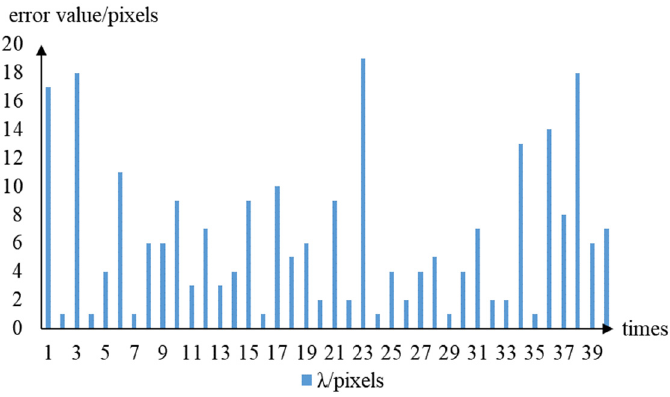
Figure 16. Pixel error value of lower extreme point. Abscissa, number of trials and ordinates, pixel error value.